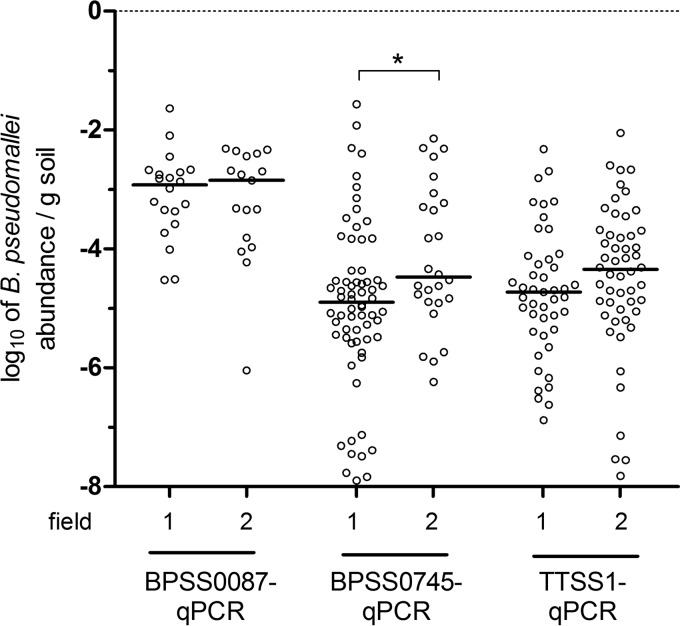
Abundance of B. pseudomallei in single soil samples on fields 1 and 2. The scatter plot (with medians) of B. pseudomallei abundance is given as log10 of GE (TTSS1, BPSS0087, and BPSS0745 qPCR) per 16S rRNA gene. *, P < 0.05 by a Mann-Whitney U test.